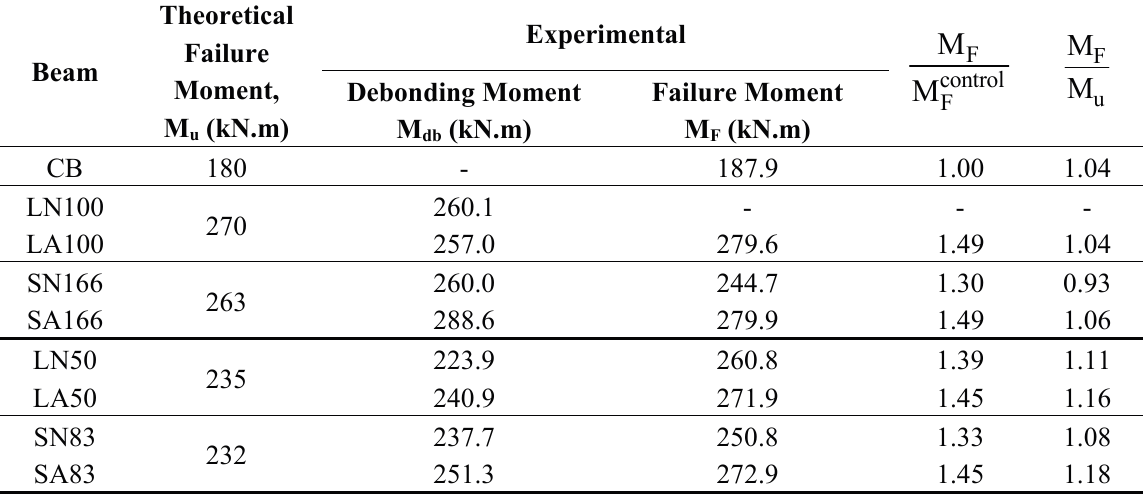
Table 3. Theoretical and measured failure moments and measured debonding moment of test